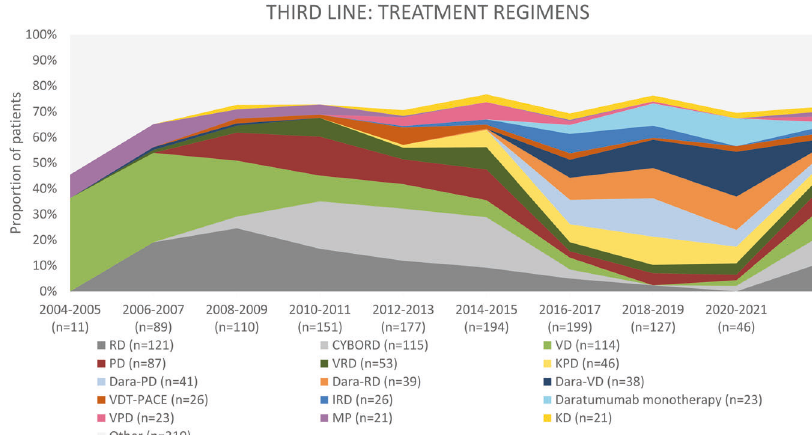
Fig. 7 Most frequently applied third-line treatment regimens in multiple myeloma patients, initiation of third-line treatment 2004 – 2021. CYBORD cyclophosphamide-bortezomib-dexamethasone, D dexamethasone, Dara daratumumab, I ixazomib, K car fi lzomib, MP melphalan- prednisone, P pomalidomide, R lenalidomide, T thalidomide, V bortezomib, VDT-PACE bortezomib, dexamethasone, thalidomide, cisplatin, doxorubicin, cyclophosphamide, and